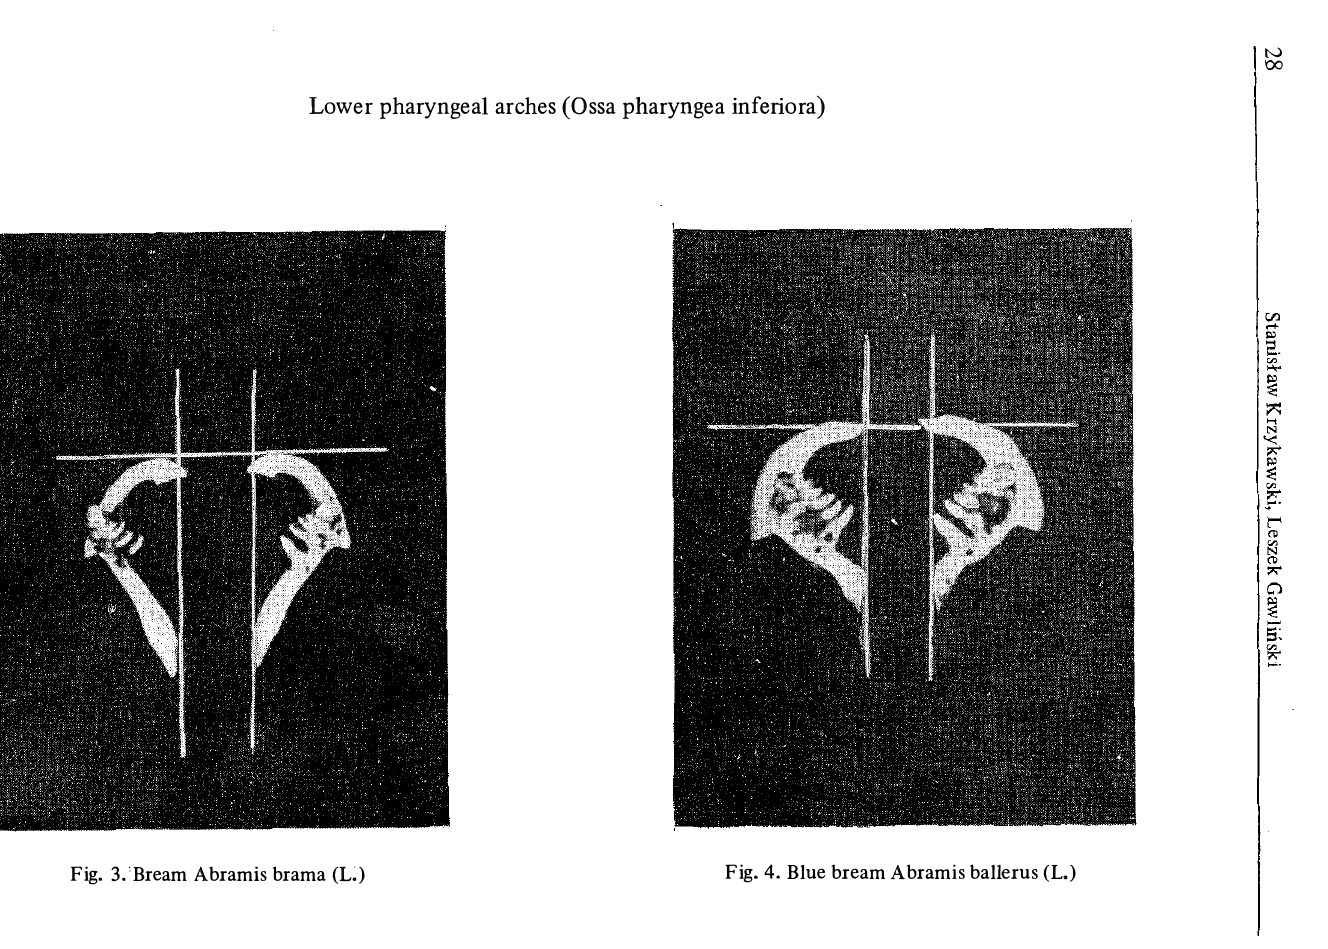
Fig. 3.'Bream Abramis brama (L) Fig. 4. Blue bream Abramis ballerus